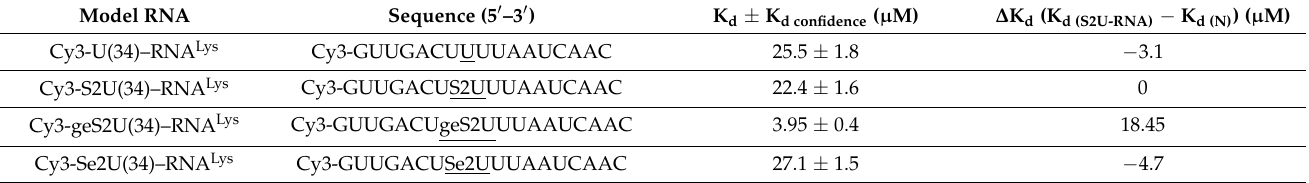
Table 3. Results of the MST measurements of the relative dissociation constants (K d ) for each pair of interacting molecules: MBP–SelU:Cy3-U(34)–RNA, MBP–SelU:Cy3-S2U(34)–RNA, MBP–SelU:Cy3- geS2U(34)–RNA, and MBP–SelU:Cy3-Se2U(34)–RNA. Model